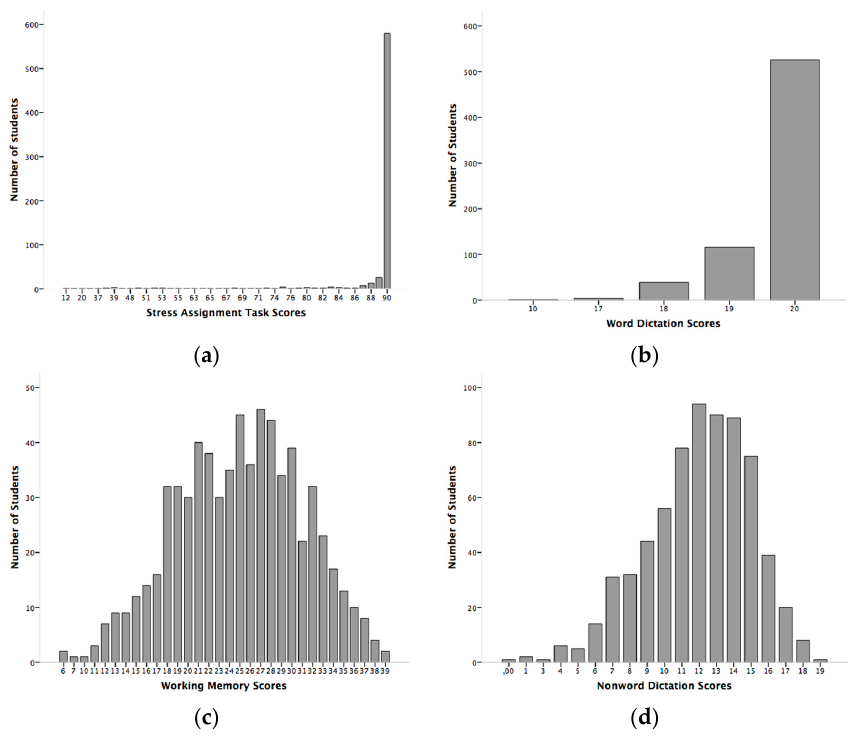
Figure 2. Distributions of Single Task Scores: ( a ) Stress Assignment; ( b ) Word Dictation Scores; ( c) Working Memory Task; ( d ) Nonword Dictation.